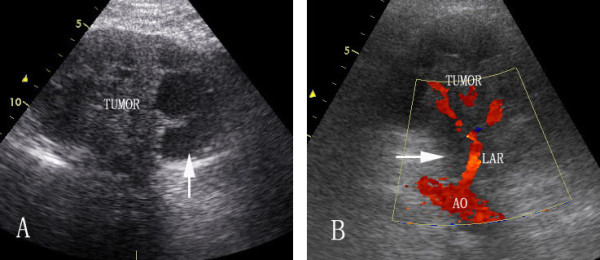
Ultrasound showing left renal tumor. A: Ultrasound revealed hypoechoic masses (arrow) with ill-defined border in the central region around renal sinus. B: Color doppler flow imaging of mass (arrow) indicated decreased blood flow signals. The tumor invaded renal pelvis inward and infiltrated vessel pedicle outward, and caused caliectasis. AO: abdominal aorta; LRA: left renal artery.